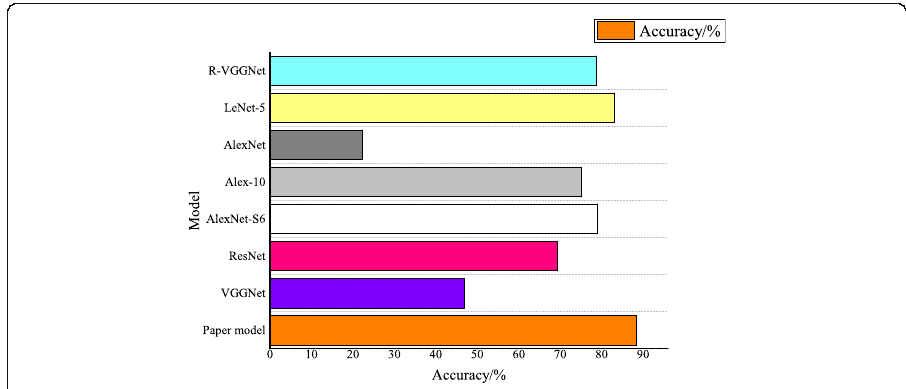
Fig. 9 Comparison of the accuracies of different models